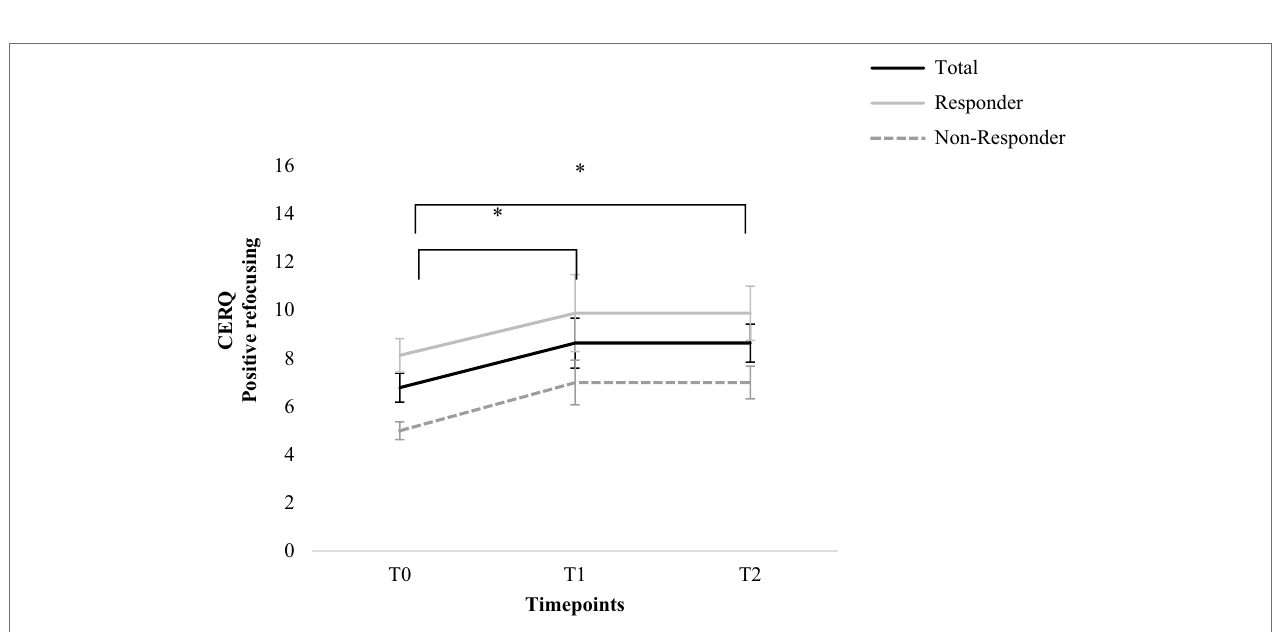
FIGURE 4 | Change in the WHO Quality of Life Questionnaire–BREF psychological health score for total sample, responders, and non-responders. Error bars represent standard errors. * = p < 0.05 (total sample).